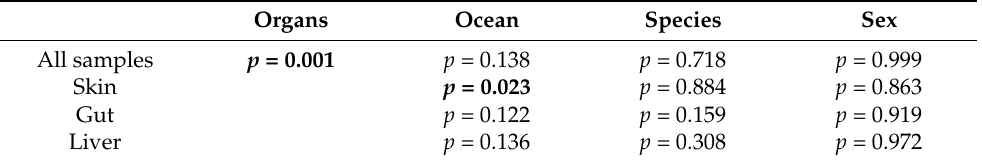
Table 1. Effects of the organ, sampling site, tuna species and sex on the diversity of viral communities assessed with permutational ANOVAs (PERMANOVA, 999 permutations) based on Bray–Curtis dissimilarity matrices. Bold values indicate a significant effect of the tested factor ( p < 0.05). Organs Ocean Species Sex All samples p = 0.001 p = 0.138 p = 0.718 p = 0.999 Skin p = 0.023 p = 0.884 p = 0.863 Gut p = 0.122 p = 0.159 p = 0.919 Liver p = 0.136 p = 0.308 p =